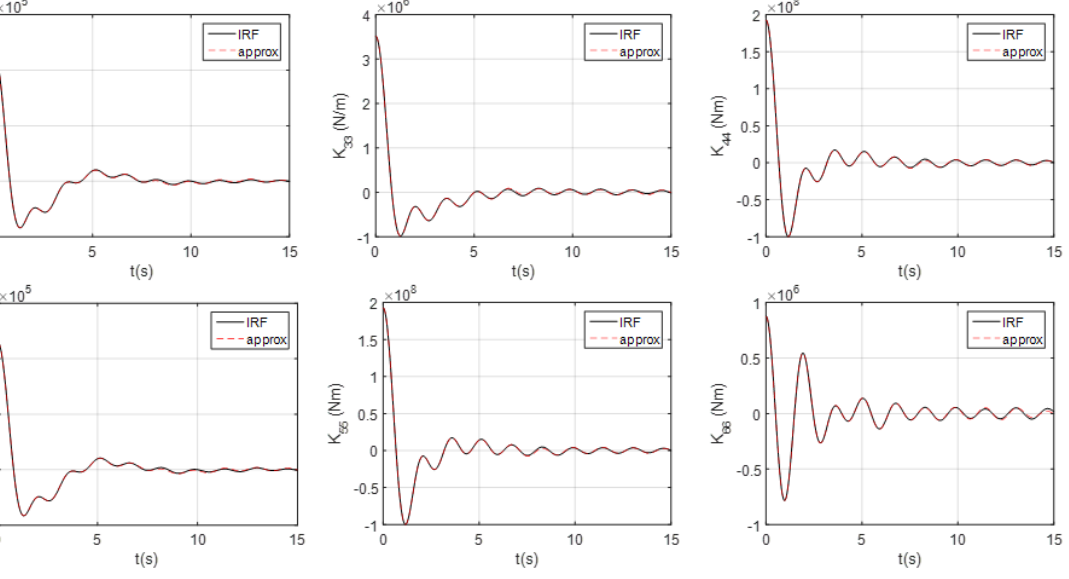
Figure 10. Conventional impulse functions ( 𝑁 0 = 10): in the figure, ‘IRF’ means the impulse response function, calculated based on the results from the panel method, while ‘approx’ is the Prony approximation, calculated from Equation (14).